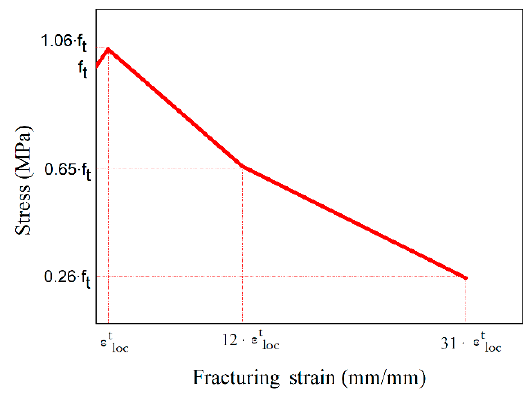
Figure 9. Constitutive modelling for UHPFRC.